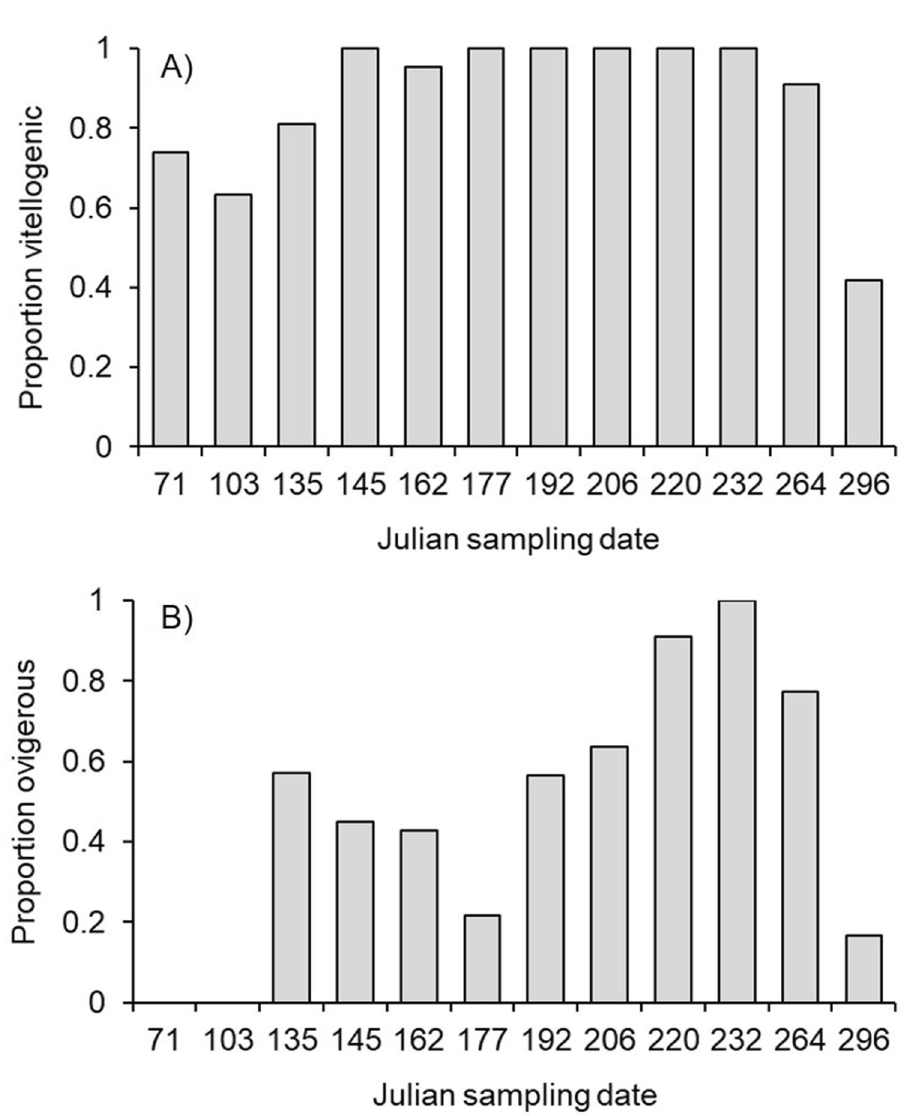
Figure 1. Proportion of Aratus pisonii that were vitellogenic ( A ) and ovigerous ( B ) on each Julian sampling date, showing a unimodal distribution consistent with a defined reproductive